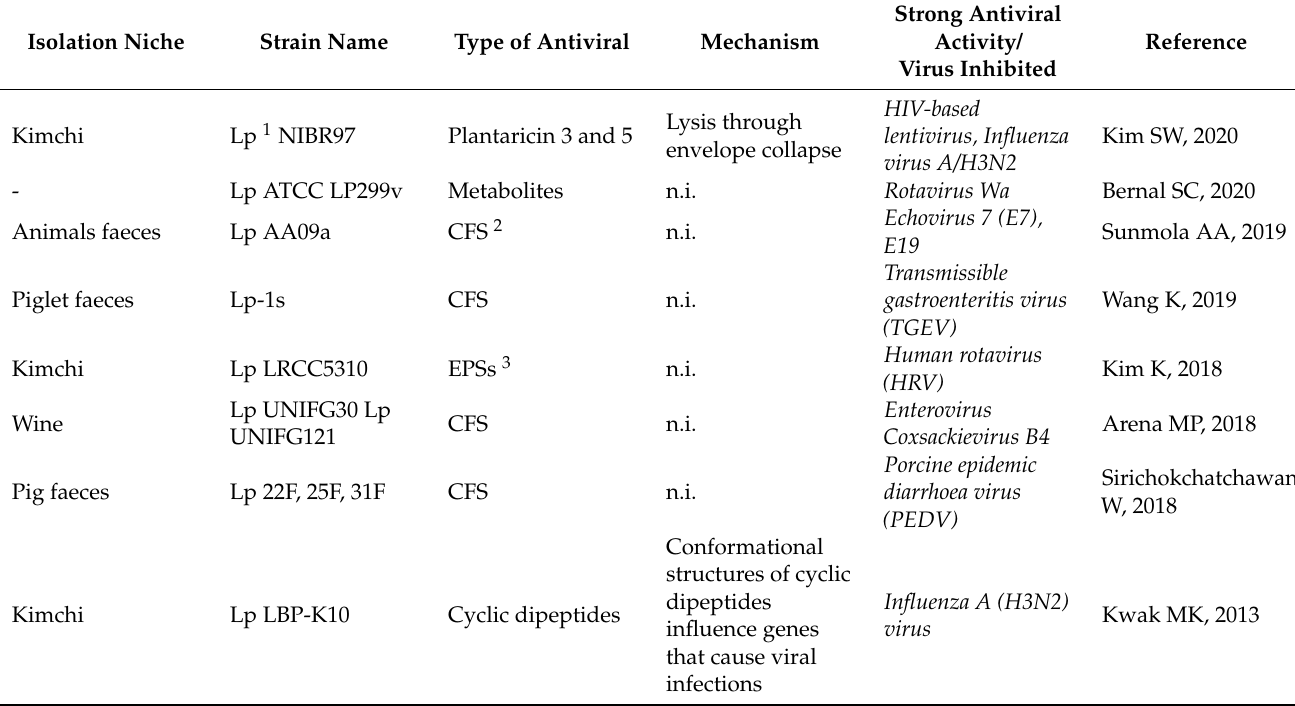
Table 2. Probiotic L. plantarum strains with documented in vitro antiviral